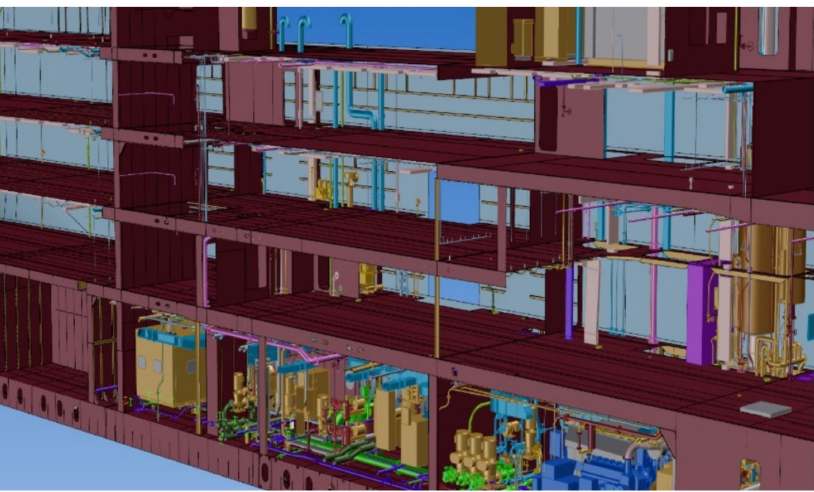
Figure 7. CAD representation model of a ferry longitudinal section.